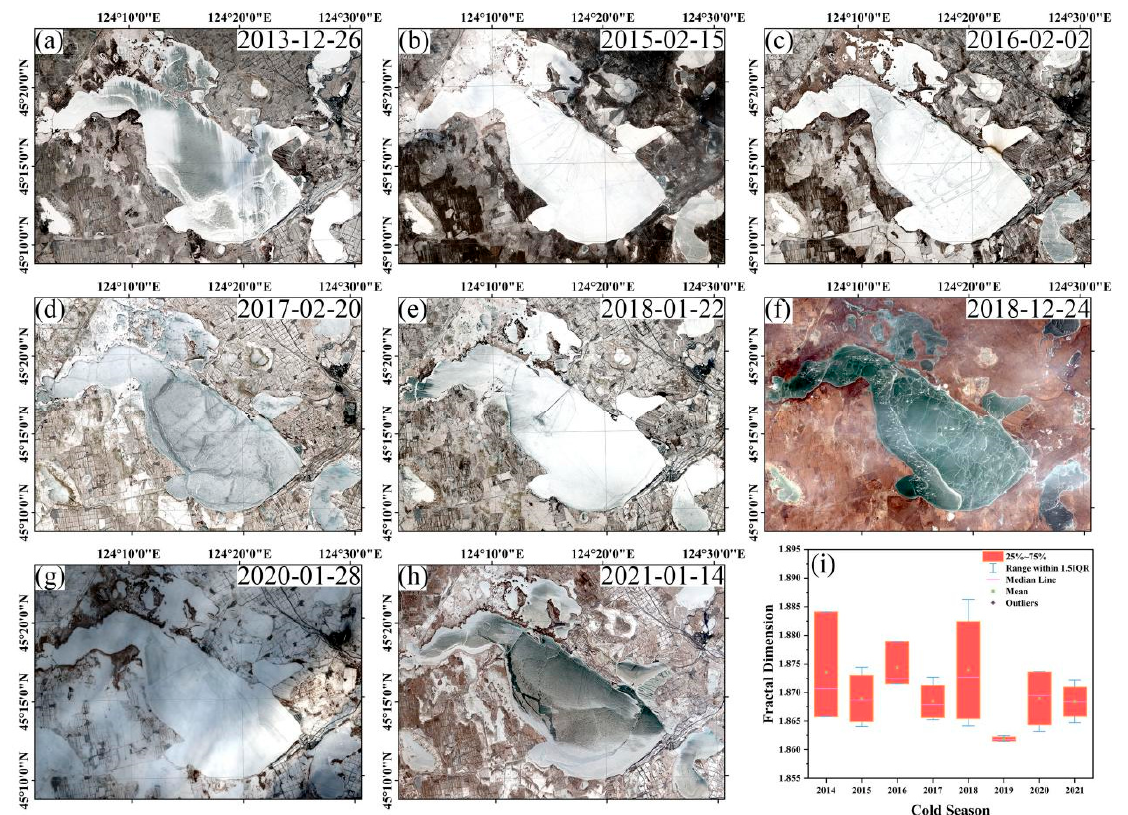
Figure 7. The satellite images of the frozen Chagan Lake ( a – h ) with the largest D values for each cold season and the boxplot of fractal dimension D ( i ).